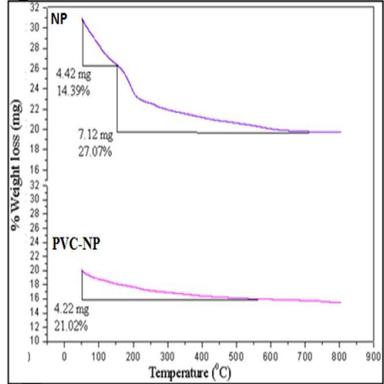
TGA spectral analysis of only NP and PVC–NP composite material.